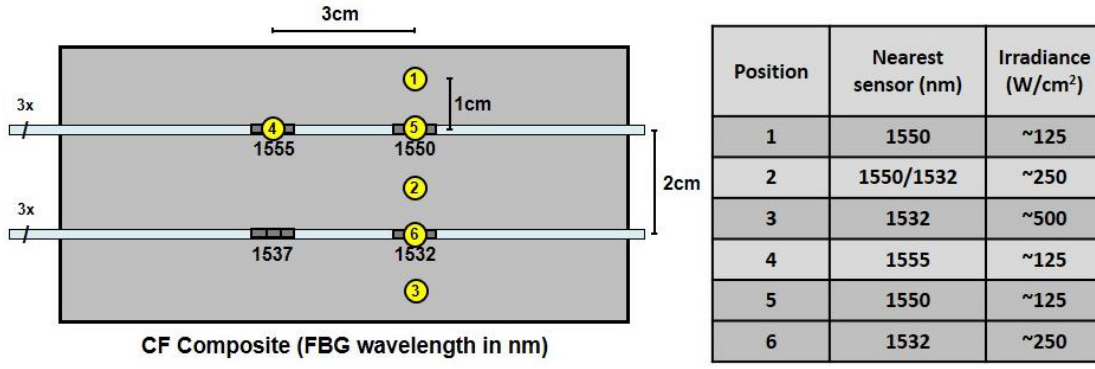
Figure 10. Locations and test conditions for six laser strikes on CF composite structure from Figure 9.